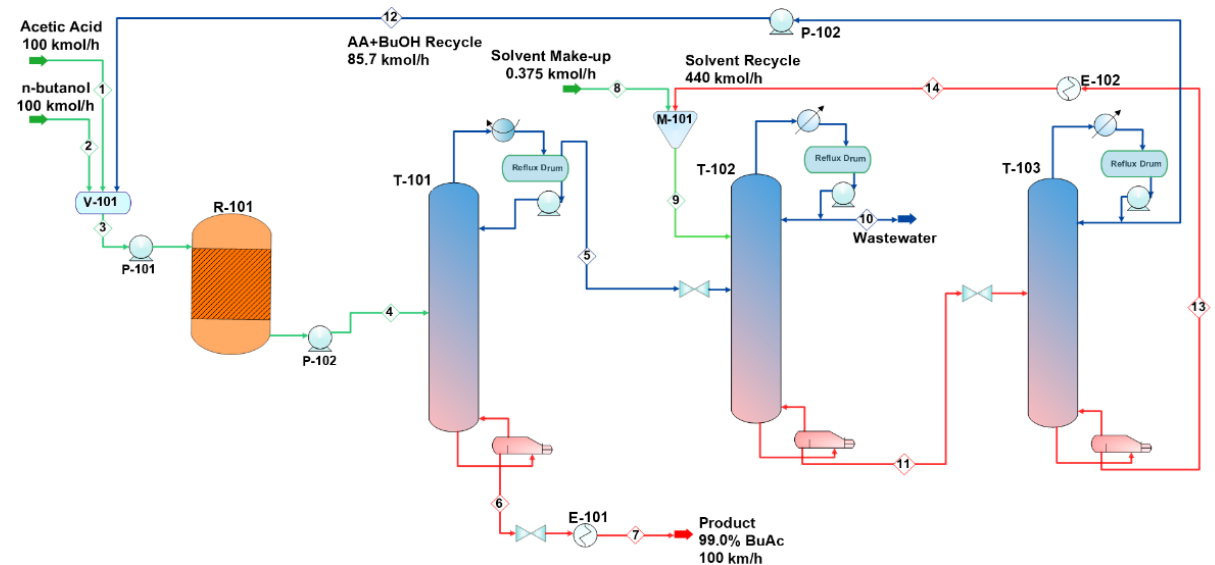
Figure 11. Conventional process flow diagram (PFD) for n -butanol esterification with acetic acid.